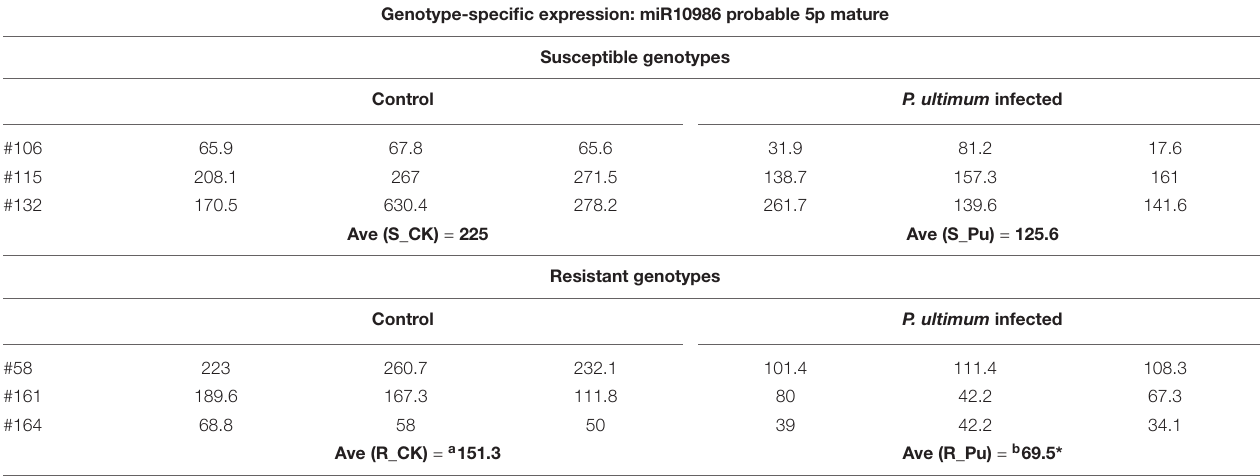
TABLE 7 | The genotype-specific expression of miR10986 and target genes in response to Pythium ultimum infection of apple roots. Genotype-specific expression: miR10986 probable 5p mature